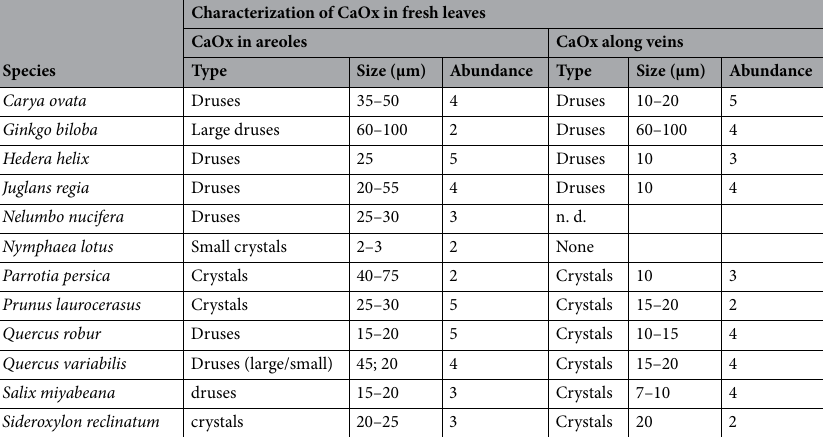
Table 2. Distribution pattern, size and abundance of calcium oxalate (CaOx) crystals and druses in leaves of extant species presented in this study. Abundance of the CaOx bodies is indicated with numbers. 1 =